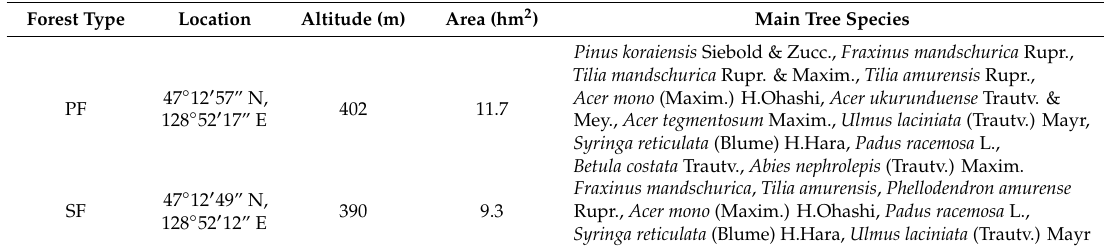
Table 1. Overview of the sample sites.